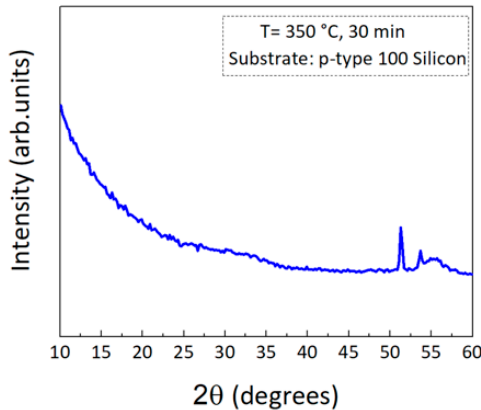
Figure 10. Grazing incidence XRD diffractogram of the spin-coated ZrO x thin films annealed at 350 °C in air for 30 min and deposited on a silicon substrate. Energies 2022 , 15 , x FOR PEER REVIEW